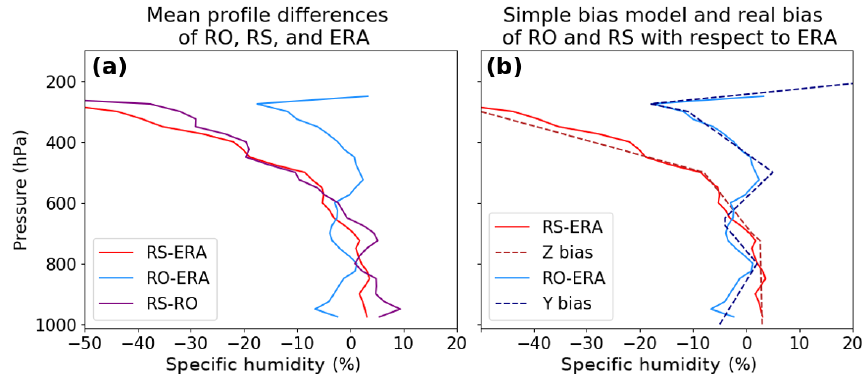
Figure 13. (a) Annual mean normalized profiles of RS–ERA, RO–ERA and RS–RO. (b) Same for RS–ERA and RO–ERA only (solid lines), and their respective empirical bias profiles (dashed lines) based on the mean profiles.